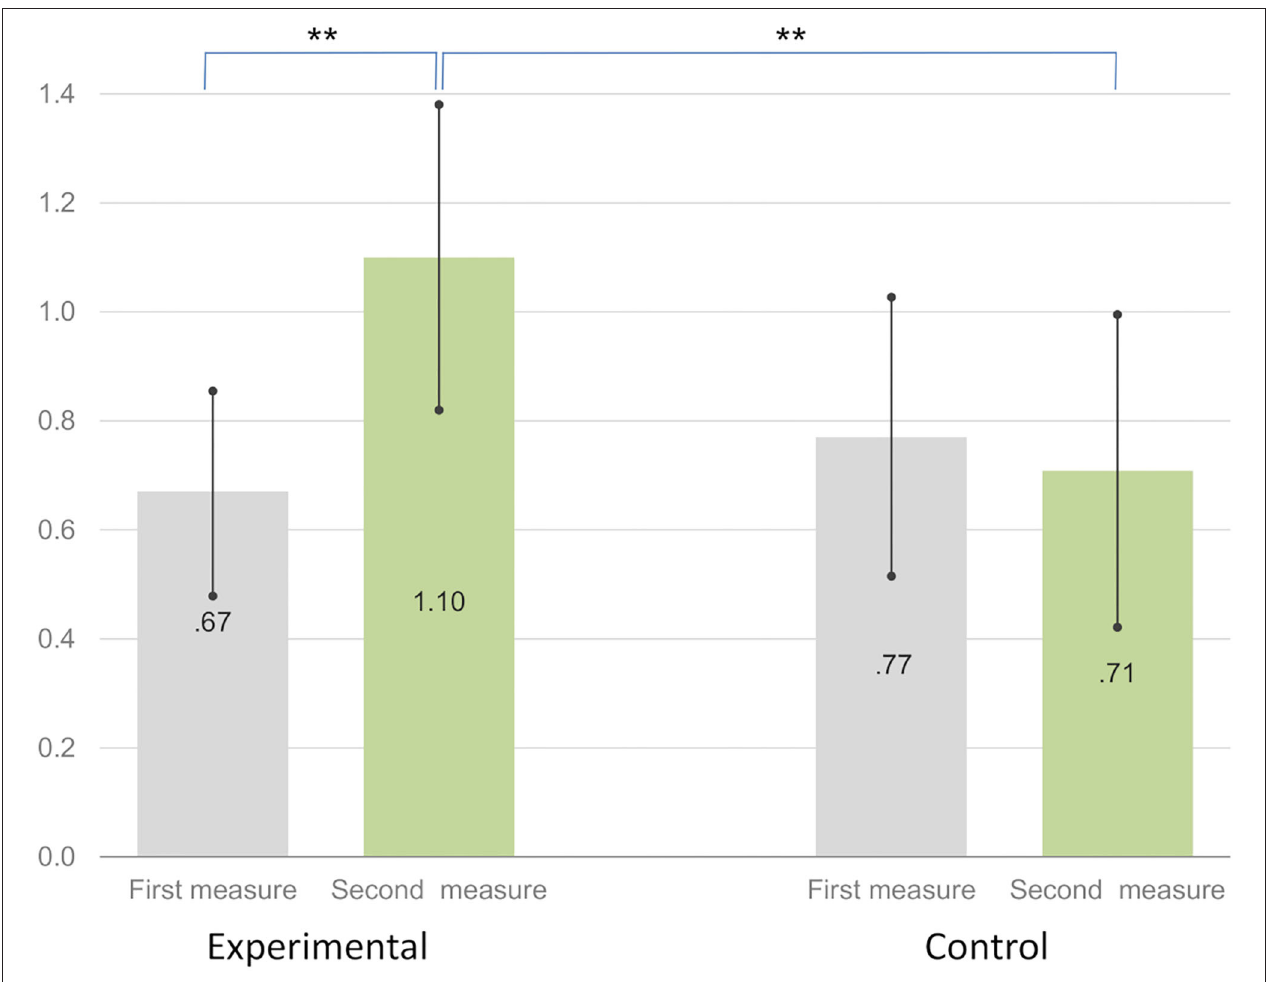
FIGURE 3 | Debt literacy change in the experimental and control groups ab . a Mean of debt literacy raw scores in the range 0–4. Significance: * p < 0.05, ** p < 0.01, *** p < 0.001. b Error bars represents 95.0% Lower and Upper CL for